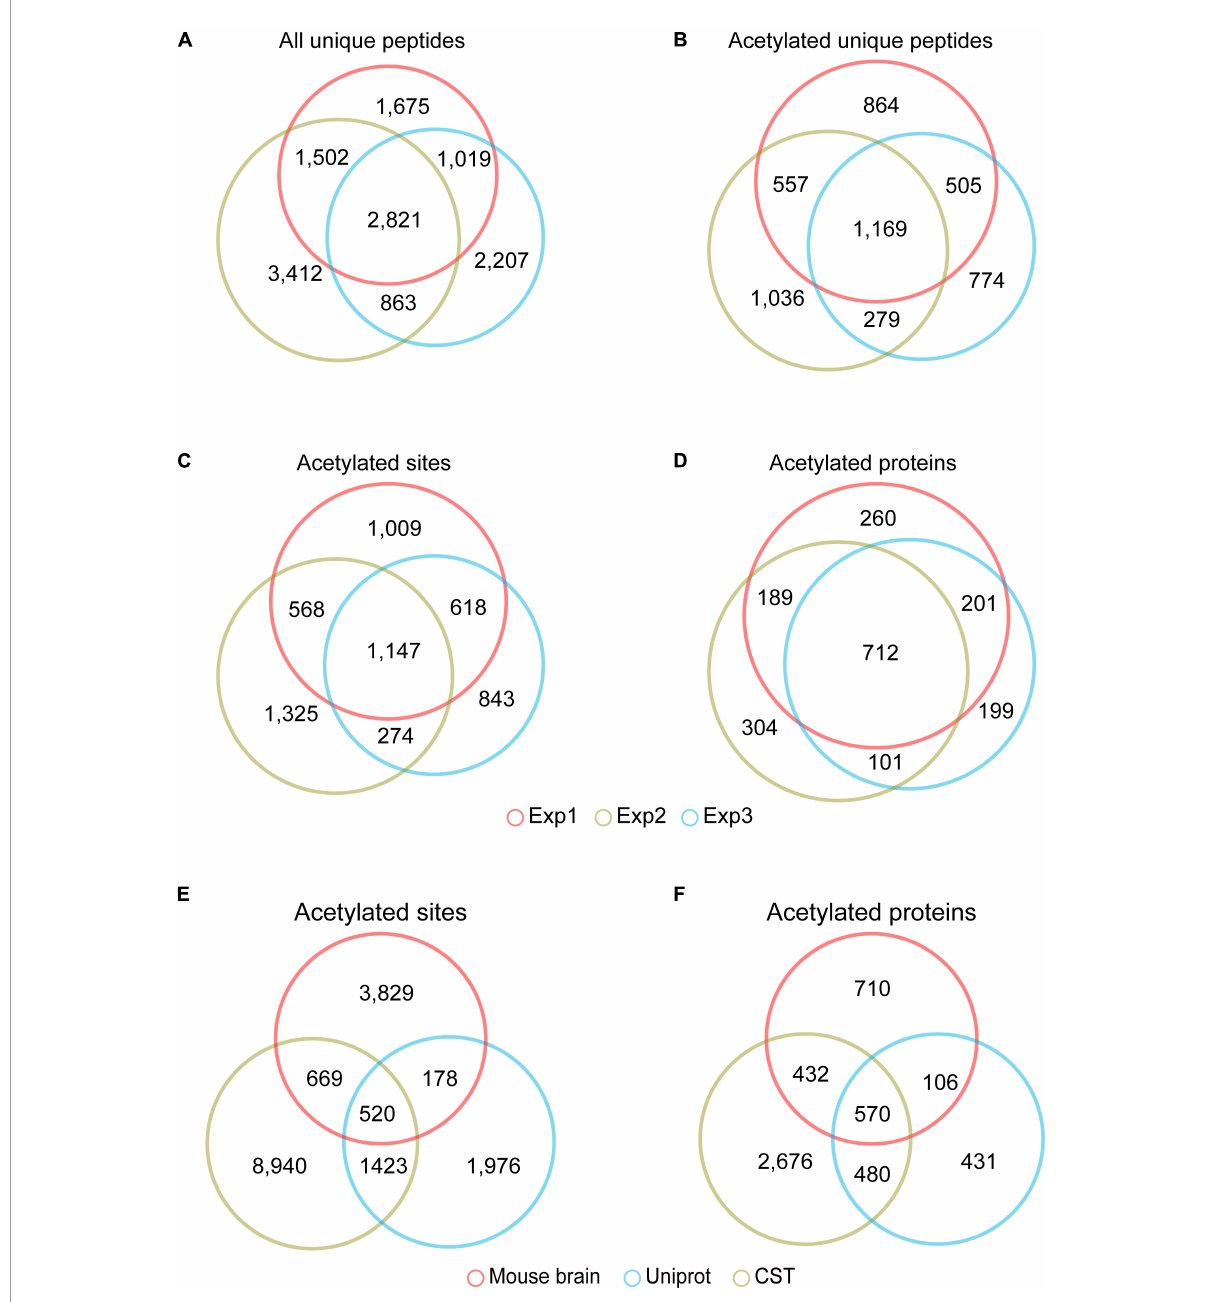
FIGURE2 The acetylome of the mouse brain. Venn diagram showed the overlapped unique peptides (A) , unique acetylated peptides (B) , acetylated proteins (C) , and acetylated sites (D) among the three independent experiments. Venn diagram showed the overlap of the acetylated lysine sites (E) and proteins (F) identified in the mouse brain and those in the PTM databases of Uniprot Swiss-Prot database (https://www.uniprot.org) and CST PhosphoSite Plus